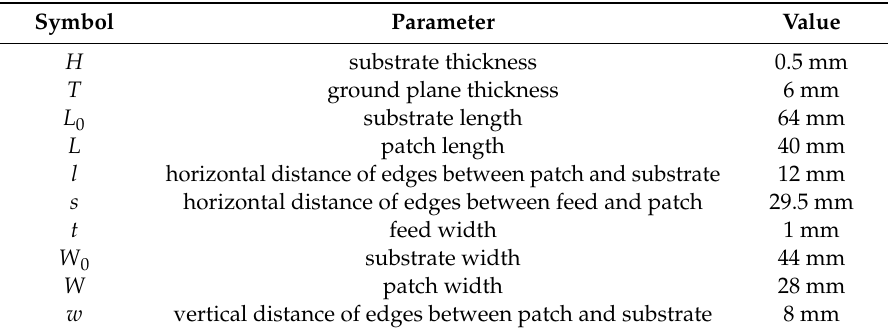
Table 1. Geometric parameters of the patch antenna sensor.